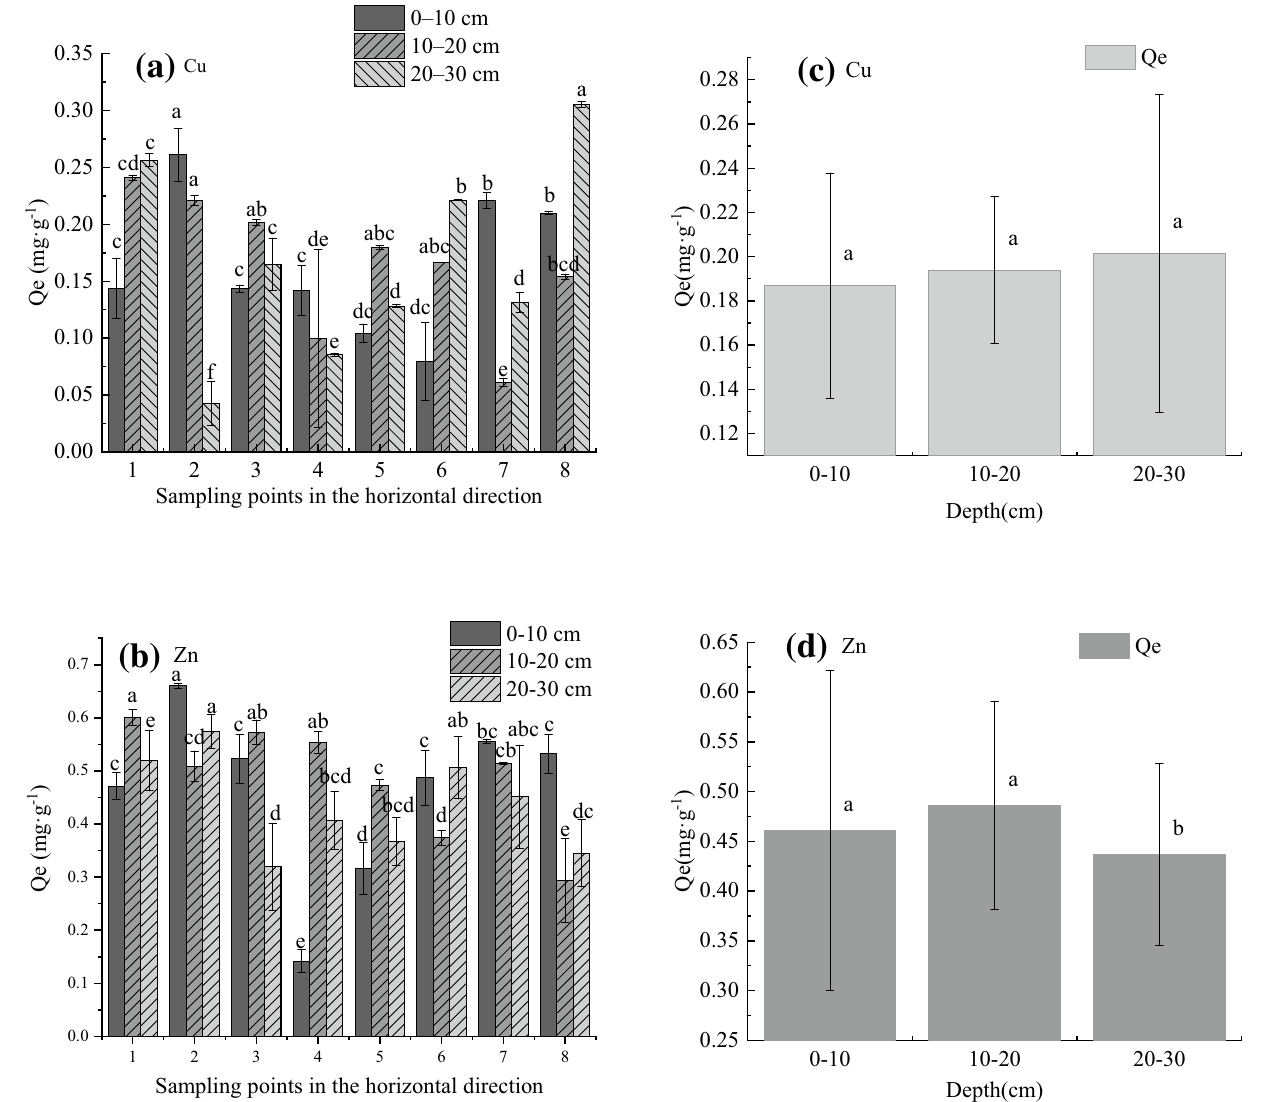
Figure 2. Effects of location along the direction of flow and different depths on Cu(II) and zinc(II) adsorbance changes. ( a ) Adsorption capacity for Cu in the flow direction, N = 8; ( b ) Adsorption capacity for Zn in the flow direction, N = 8; ( c ) Vertical change in the Cu adsorption capacity of sediments, N = 3; ( d ) Vertical change in the Zn adsorption capacity of sediments, N = 3. Different lowercase letters represent difference by Tukey test at 5% probability.